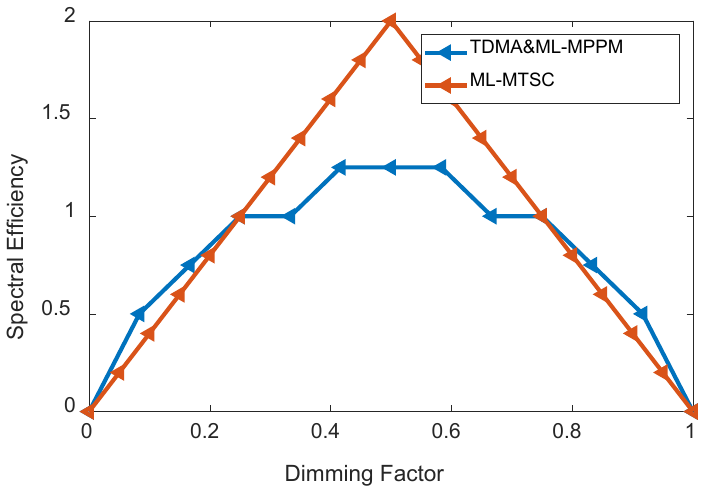
Figure 4. Spectral efficiency of the ML-MTSC scheme and the TDMA&ML-MPPM scheme.